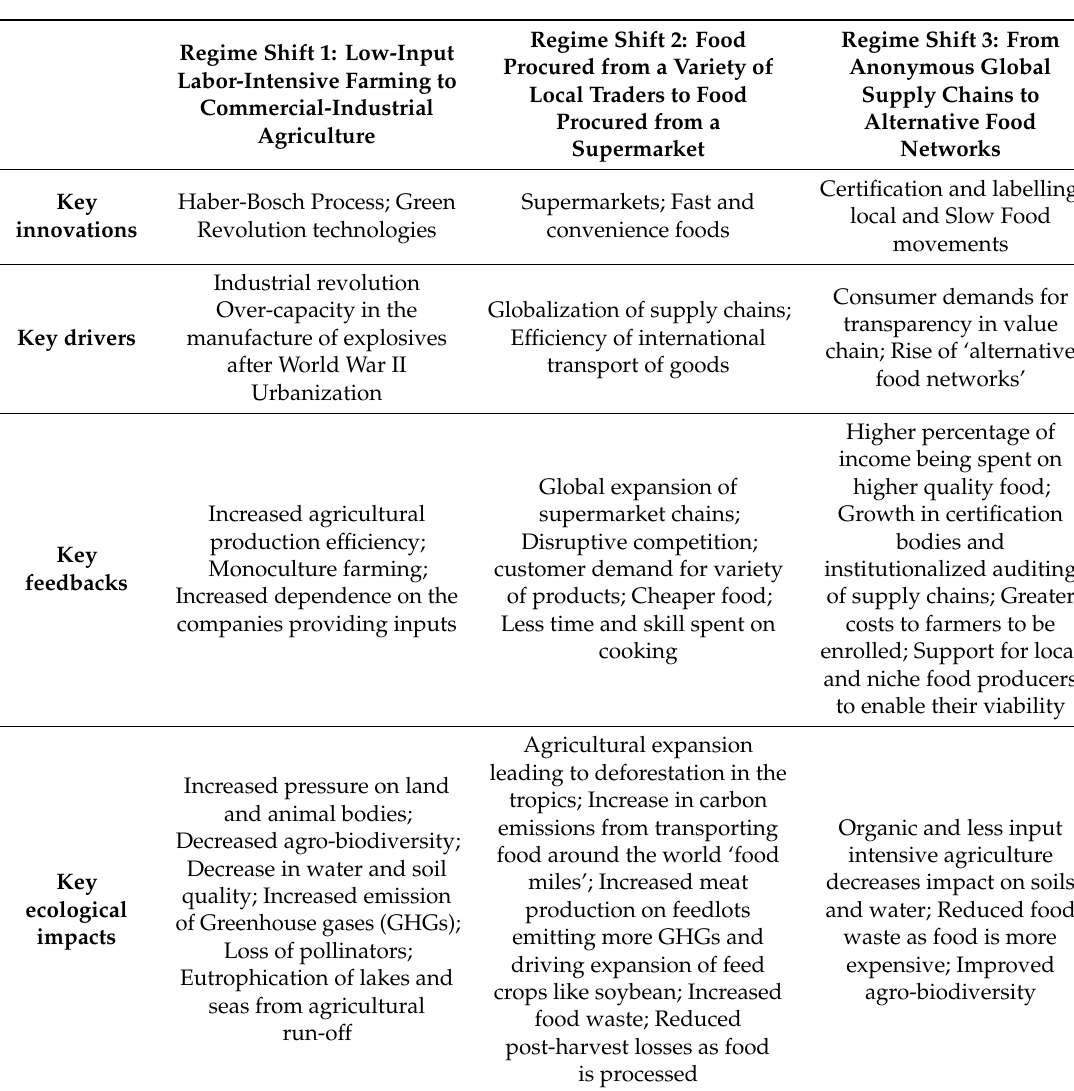
Table 1. Summary of the regime shifts in the food system linked to key characteristics used to define these